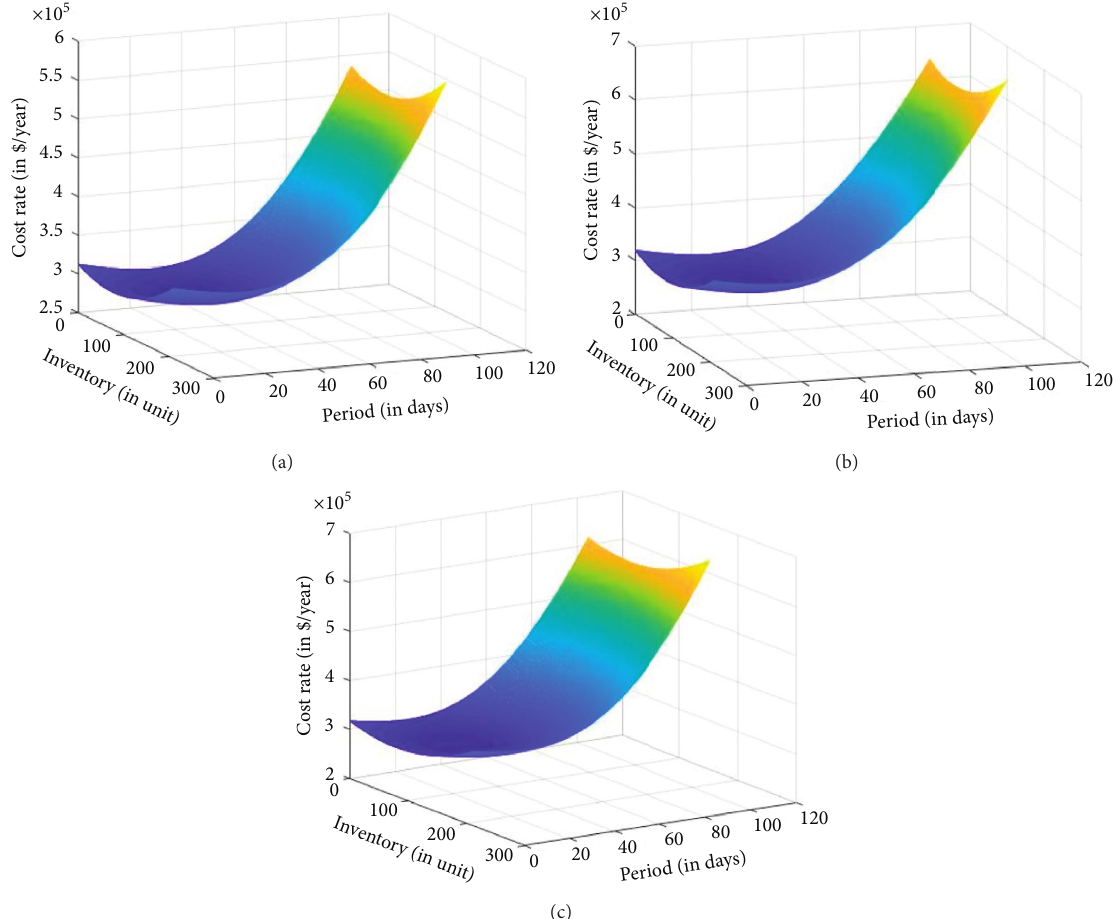
( 1 ) , M ( 2 ) , M ( 3 ) with the monitoring time T (in days) and buffer stock S (in u u u